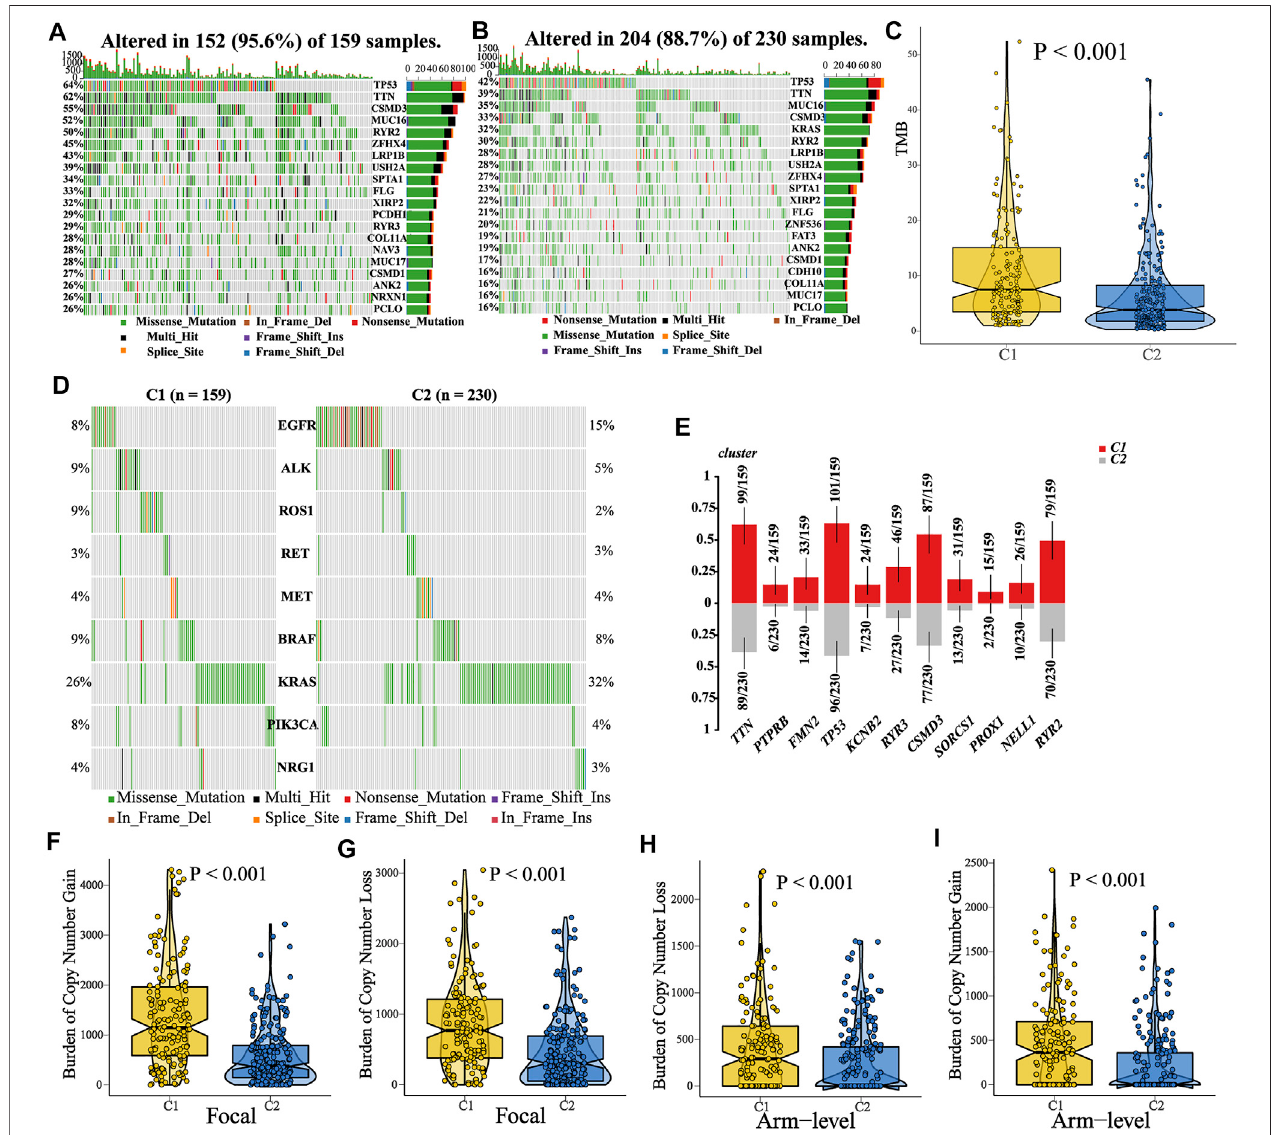
FIGURE8| ComparisonsofsomaticvariationsandcopynumberalterationburdenbetweenC1andC2. (A – B) Waterfallplotsshowedthetop20mutatedgenesin C1and C2. (C) Comparison ofTMBbetweenC1and C2,and patients inC1showed ahigher TMB. (D) Mutation landscapeofcommon driver genesofLUADinC1and C2. (E) Top 11 mutated genes enriched in patients in C1. (F – I) Comparison of CNA burden at the focal or arm level between C1 and